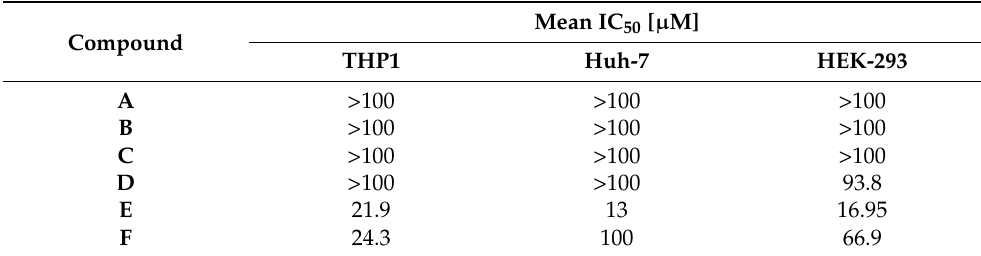
Table 3. Mean IC 50 values of compounds A – F against human cell lines THP-1, Huh-7, and Hek293. All concentrations are shown in µ M. Concentration >100 µ M indicates no activity in the experimental setup. All experiments were conducted in triplicate. The IC 50 values were calculated using GraphPad Prism 7.